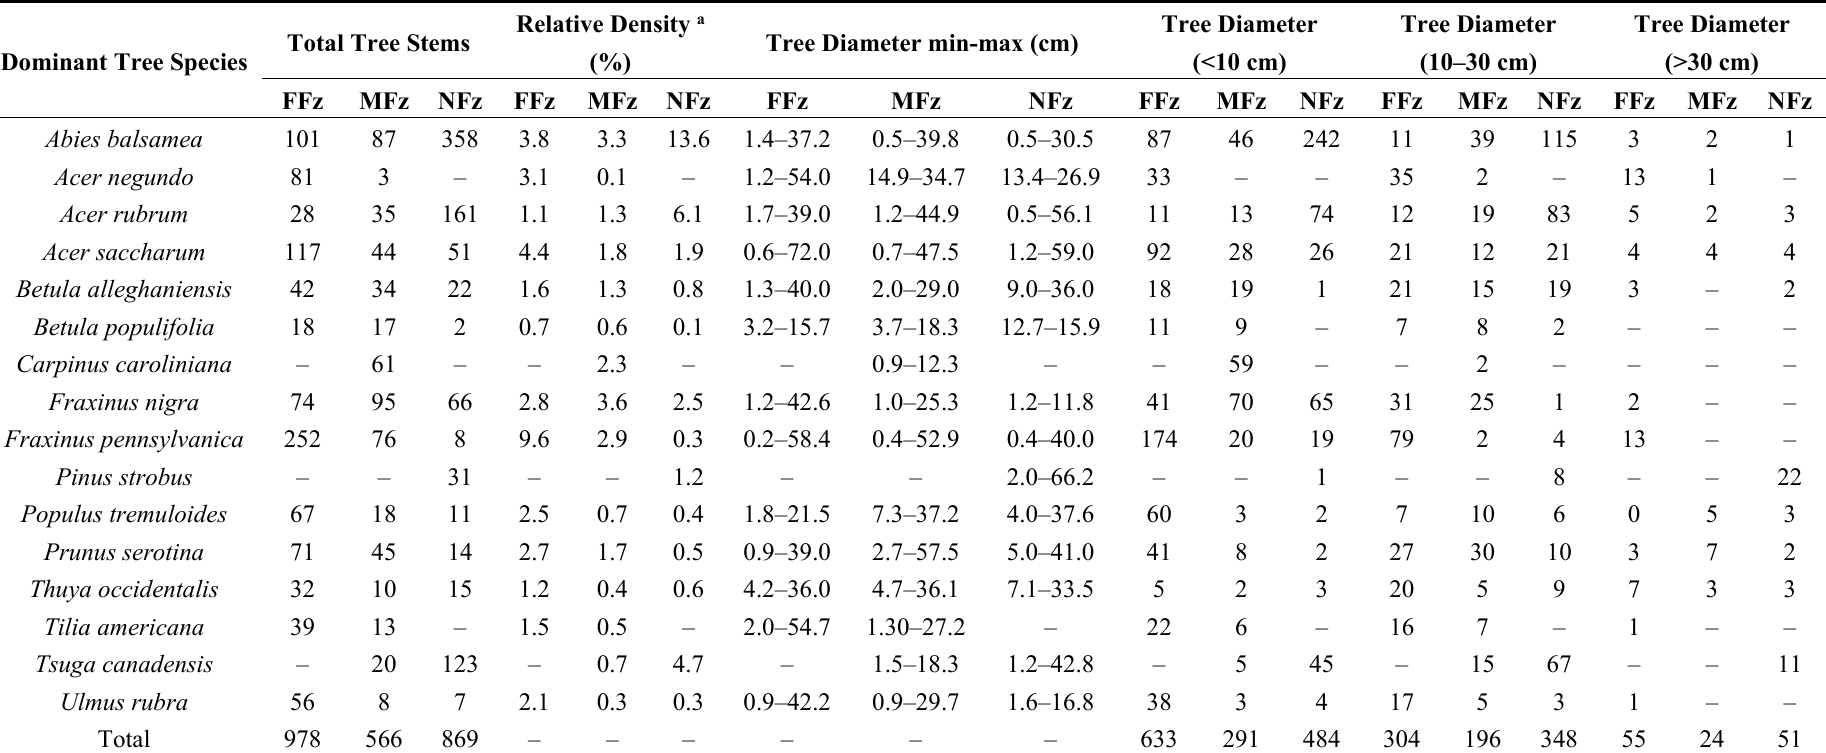
Table 3. Characteristics of quadrats in the two flood zones (FFz and MFz) and outside the floodplains (NFz) along the Massawippi and Saint-François rivers in southern Québec, Canada. Total Tree Dominant Tree Species